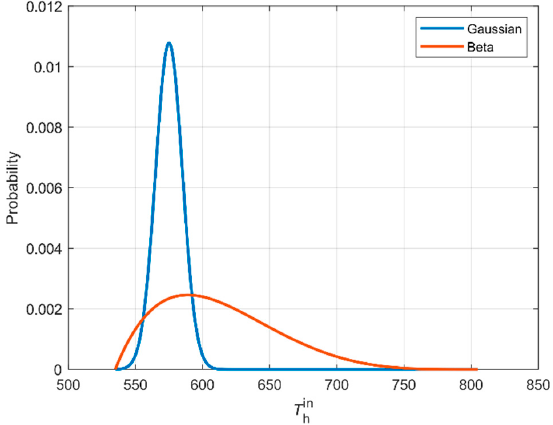
Figure 8. Hot inlet temperature probability distribution.